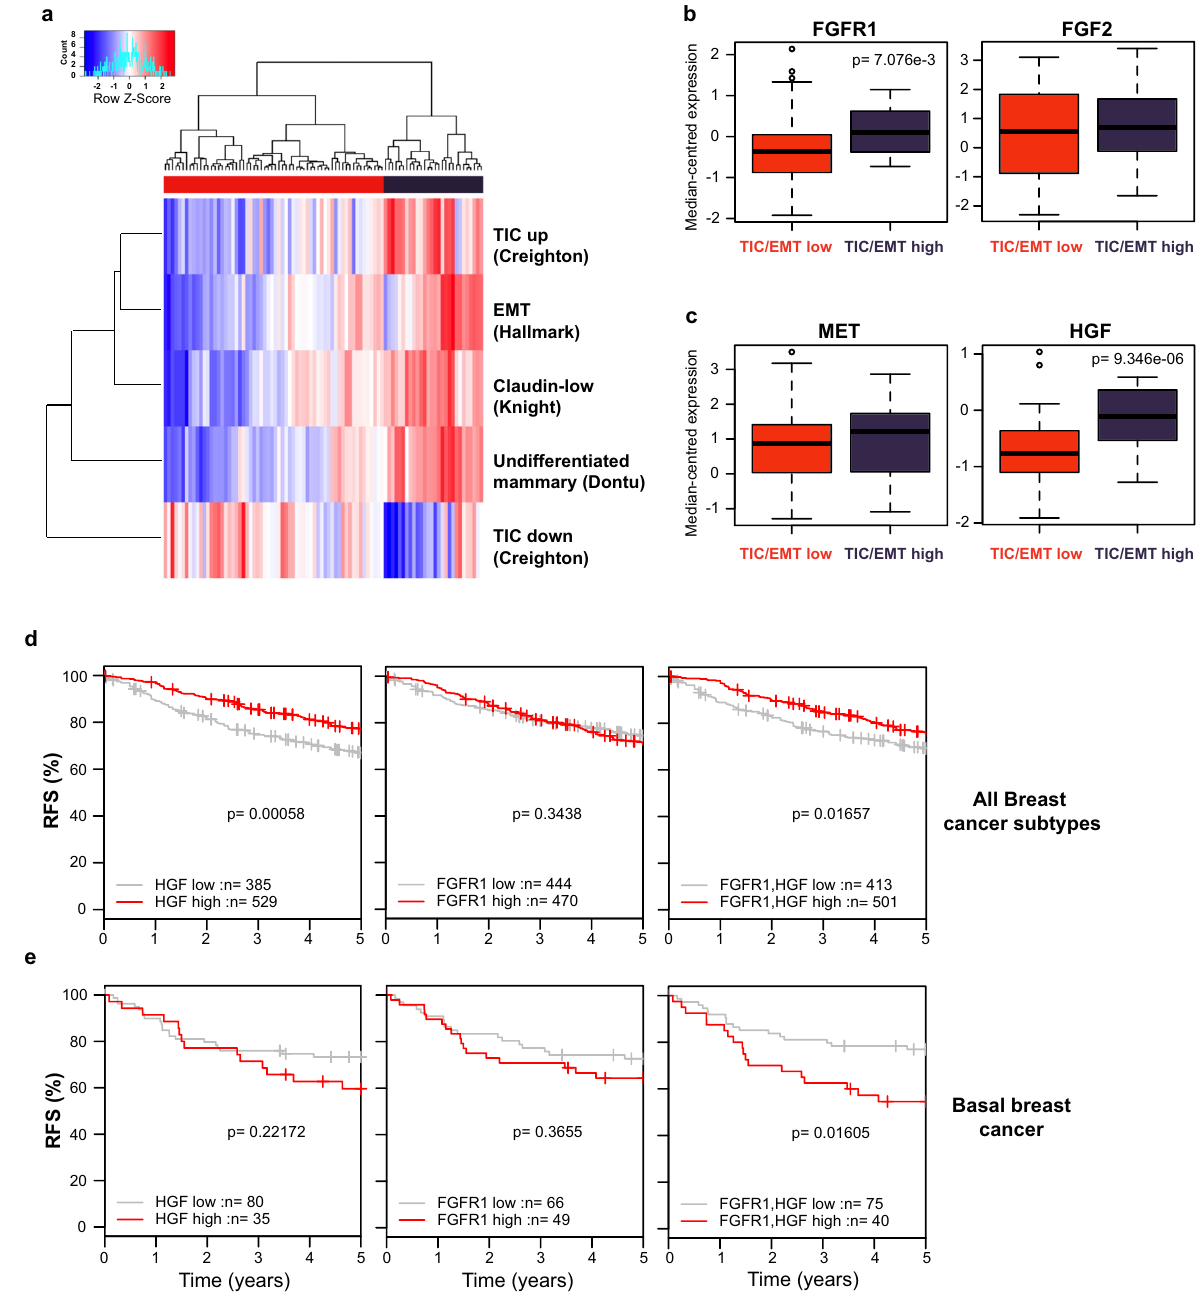
Fig. 8 HGF and FGFR1 are co-expressed in highly mesenchymal TNBC tumours and together are associated with poor outcome. a Gene expression pro fi les from triple-negative tumours from the TCGA patient cohort were subjected to ssGSEA for the indicated tumour-initiating cell and mesenchymal gene signatures and strati fi ed into TIC/EMT high and low groups. b , c Box plots of median-centred expression of the indicated genes in TIC/EMT high and low patient groups. d , e Relapse-free survival (RFS) analysis across ( d ) all breast subtypes and ( e ) basal breast cancers split by expression HGF and/or FGFR1